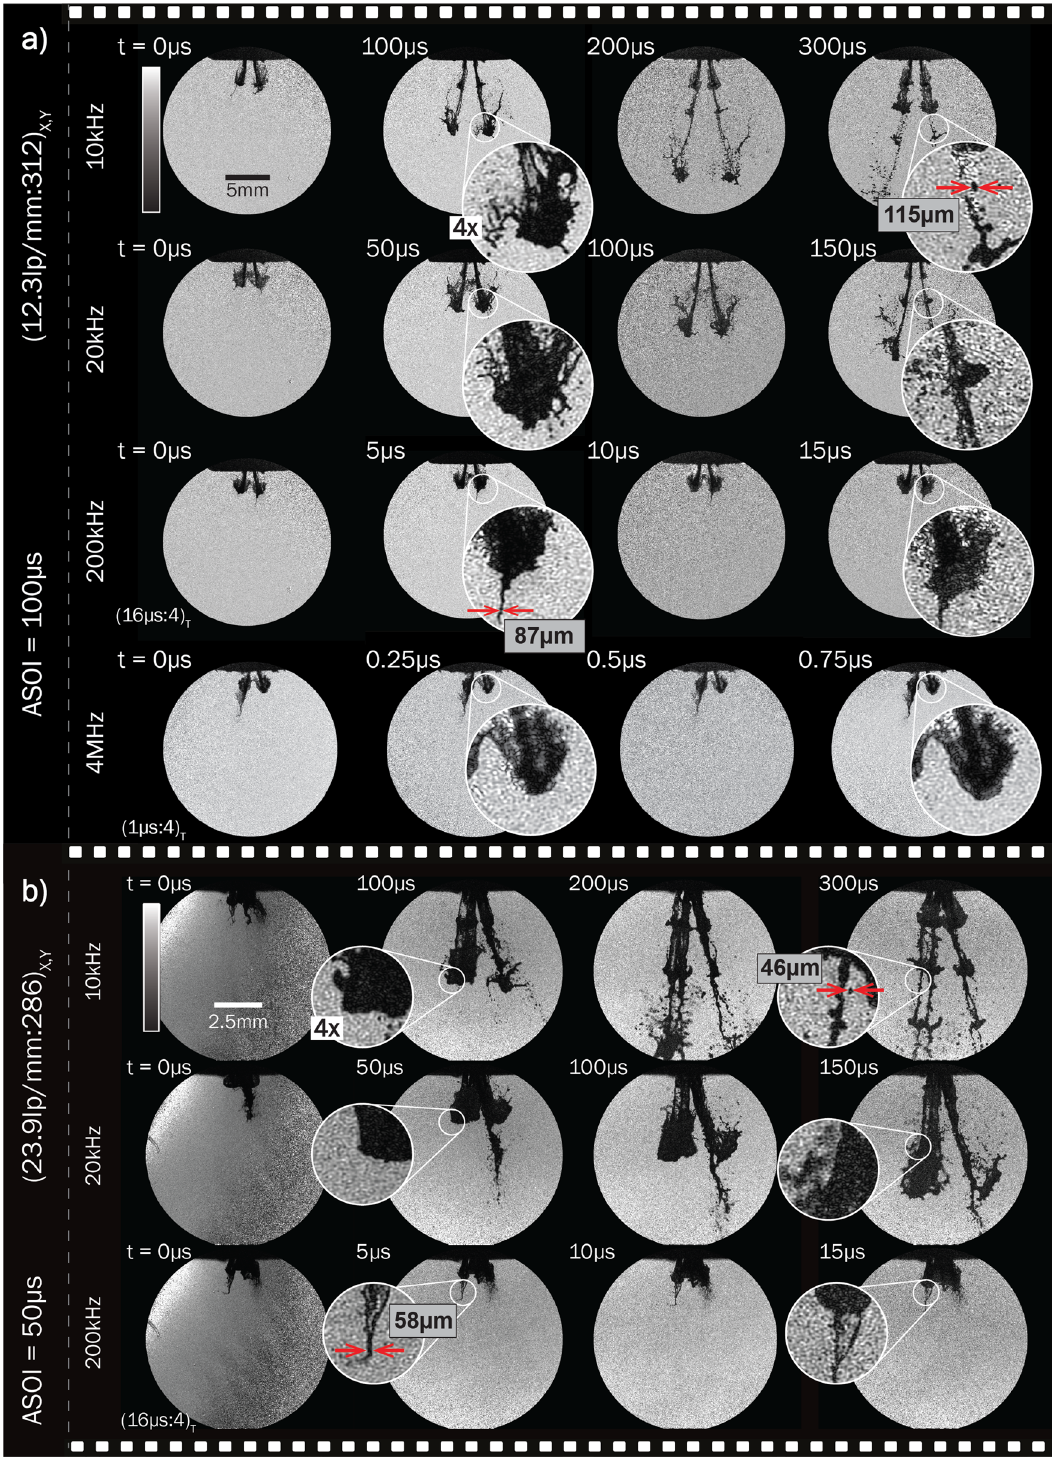
Figure 5. The versatility of speeds and magnifications allowed by the system. ( a ) shows a collection of series taken 100 μs after start of injection (ASOI) with a large FOV at speeds ranging from 10 kHz to 4 MHz. ( b ) is a collection of series taken at 50 μs ASOI and small FOV. The zoom-ins depict identical positions at different times, emphasizing the movement of the injection front at the given